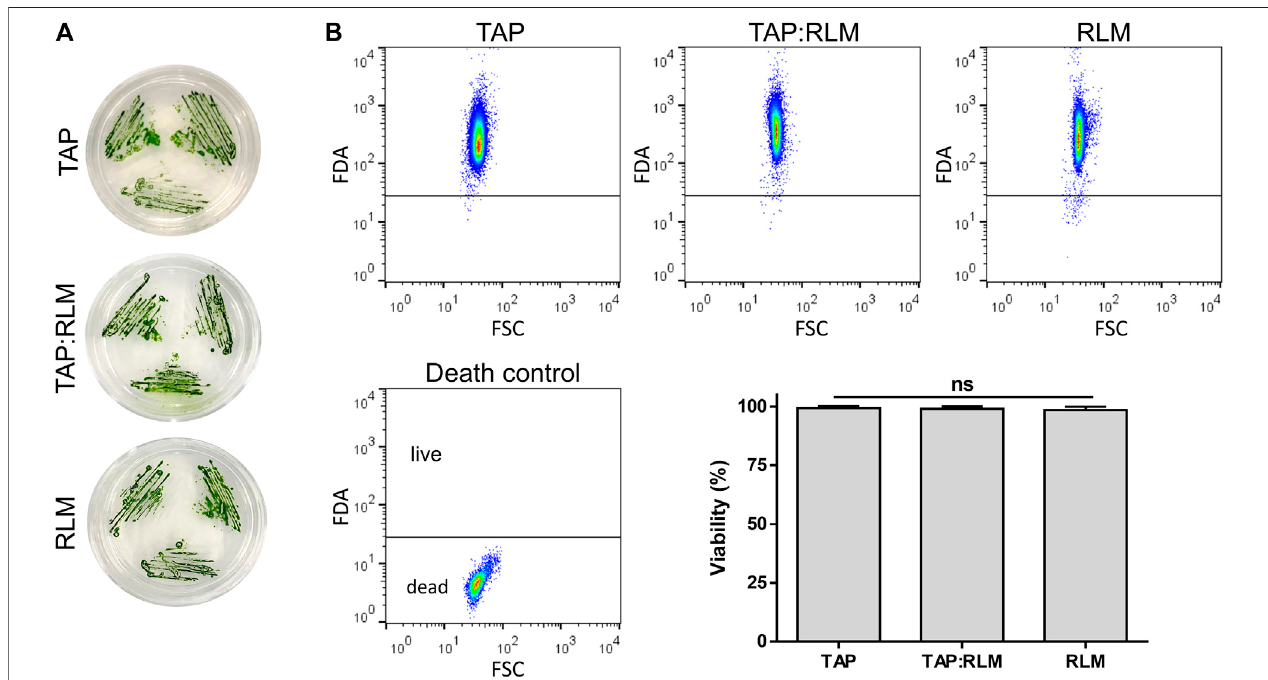
FIGURE1| Viabilityof C.reinhardtii inRLM. C.reinhardtii wereincubated for24 hintheirculturemedia(TAP),astandardsolutionfororganpreservation(RLM)ora mix of both in a 1:1 ratio (TAP:RLM). Viability of microalgae was not affected as shown by their growing capacity (A) and by fl ow cytometry (B) . Data are expressed as mean ± SD; N (cid:2) 3; ns: non-signi fi cant (one-way ANOVA